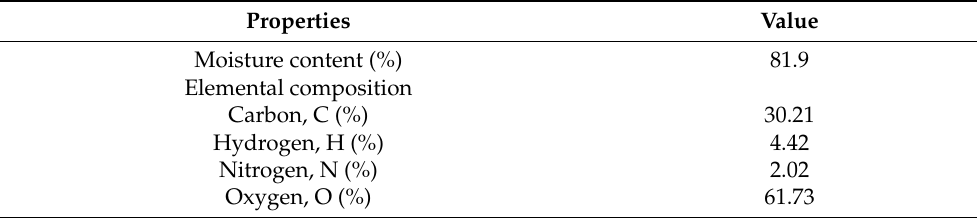
Table 1. Physiochemical properties of the studied algae, Chaetomorpha